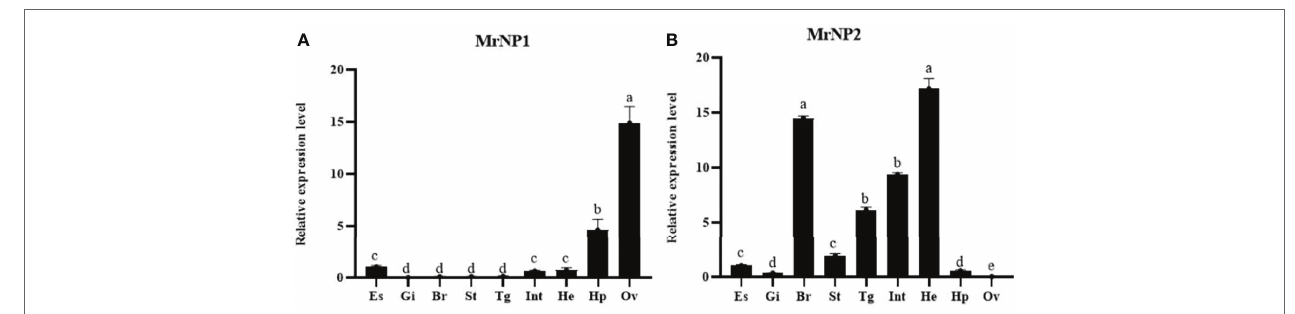
FIGURE 4 | QRT-PCR expression study of (A) MrNP1 and (B) MrNP2 in various tissues of female M. rosenbergii . Tissues used in the study are eyestalk (Es), gill (Gi), brain (Br), stomach (St), thoracic ganglion (Tg), intestine (Int), heart (Ht), hepatopancreas (Hp), and ovary (Ov). Values are relative expression level ± standard deviation (SD) (N = 5). Different letters indicate significant differences at P < 0.05 computed with ANOVA and the Tukey–Kramer